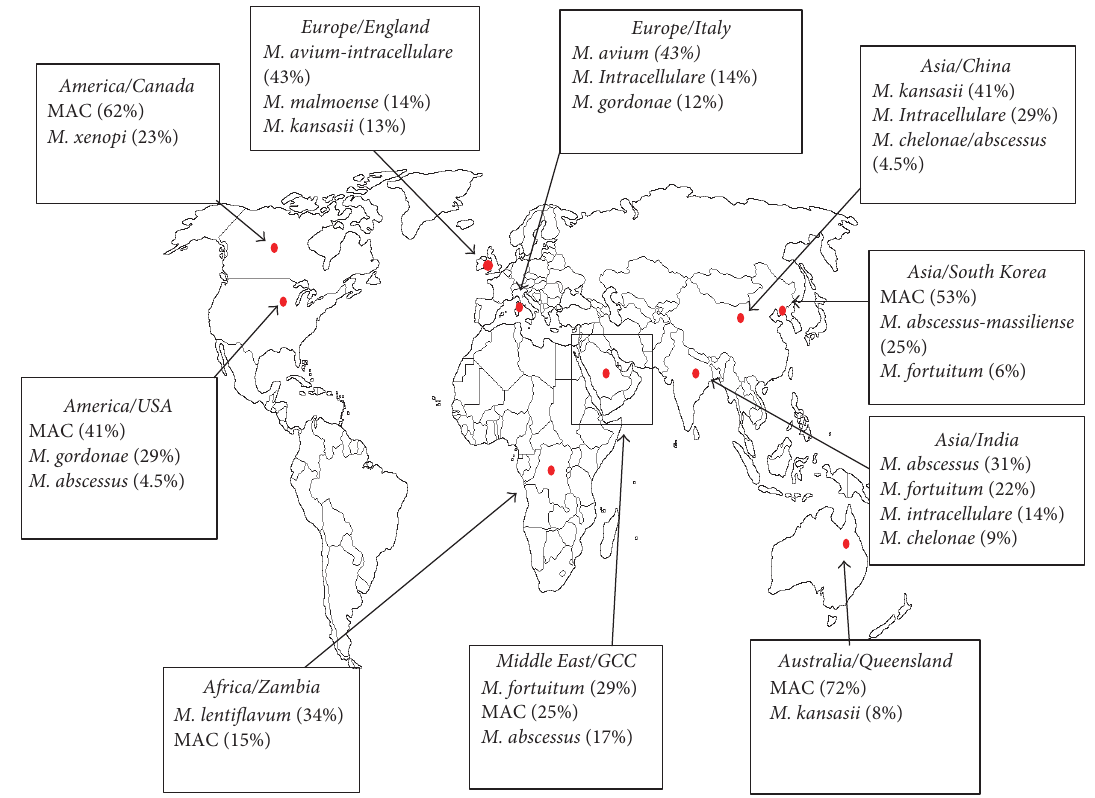
Figure 2: Worldwide geographical distribution of NTM. Showing summarized data of NTM identified from human clinical specimens in different geographical settings [19–21, 34–42,